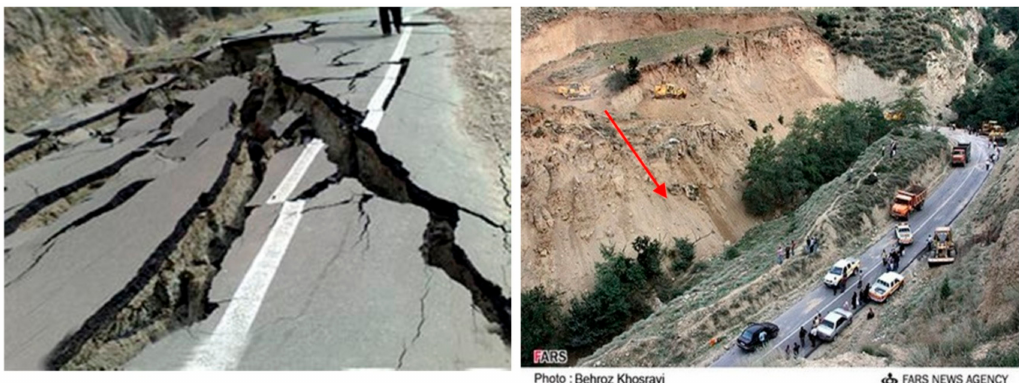
Figure 2. Some photos of landslides occurring in the area under